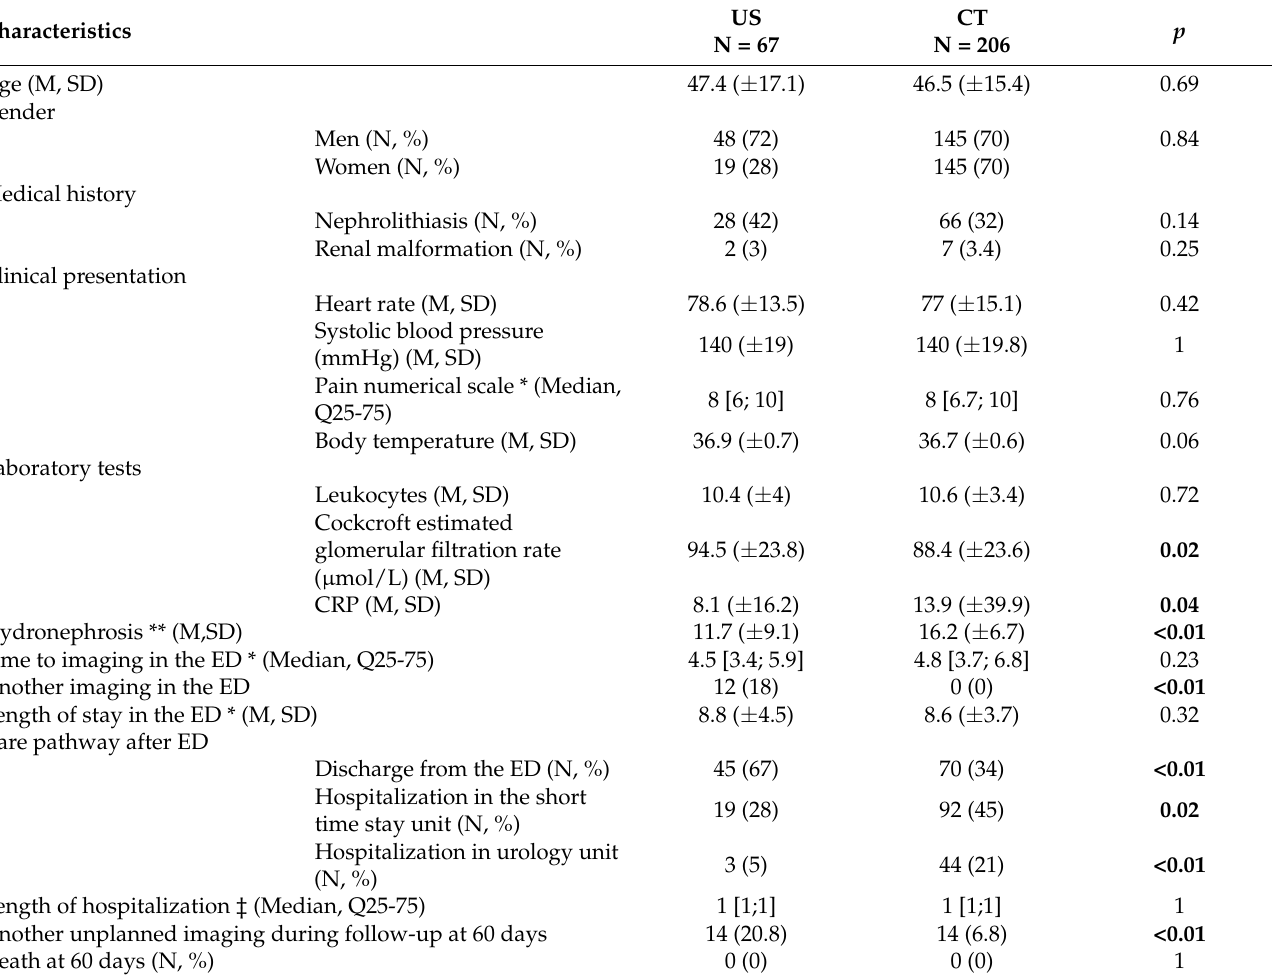
Table 1. Cohort characteristics, length of stay in the ED, and